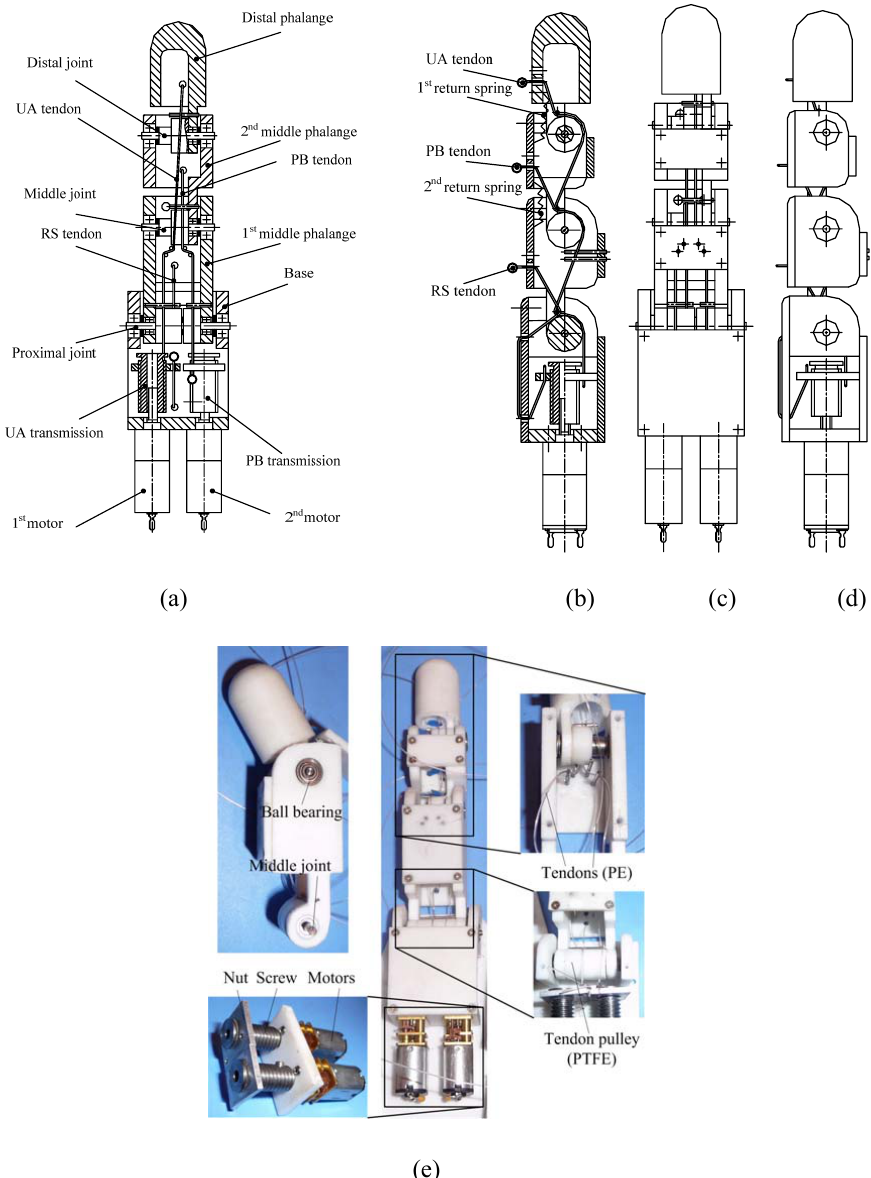
Figure 2. Structure of 3-joint GCUA-T finger. (a) Front cutaway view; (b) Side cutaway view; (c) Front view; (d) Side view; (e) 3-joint Fig. 2 Structure of 3-joint GCUA-T finger. a) Front cutaway view; b) Side cutaway view; c) GCUA-T Front view; d) Side view; e) 3-joint GCUA-T finger.